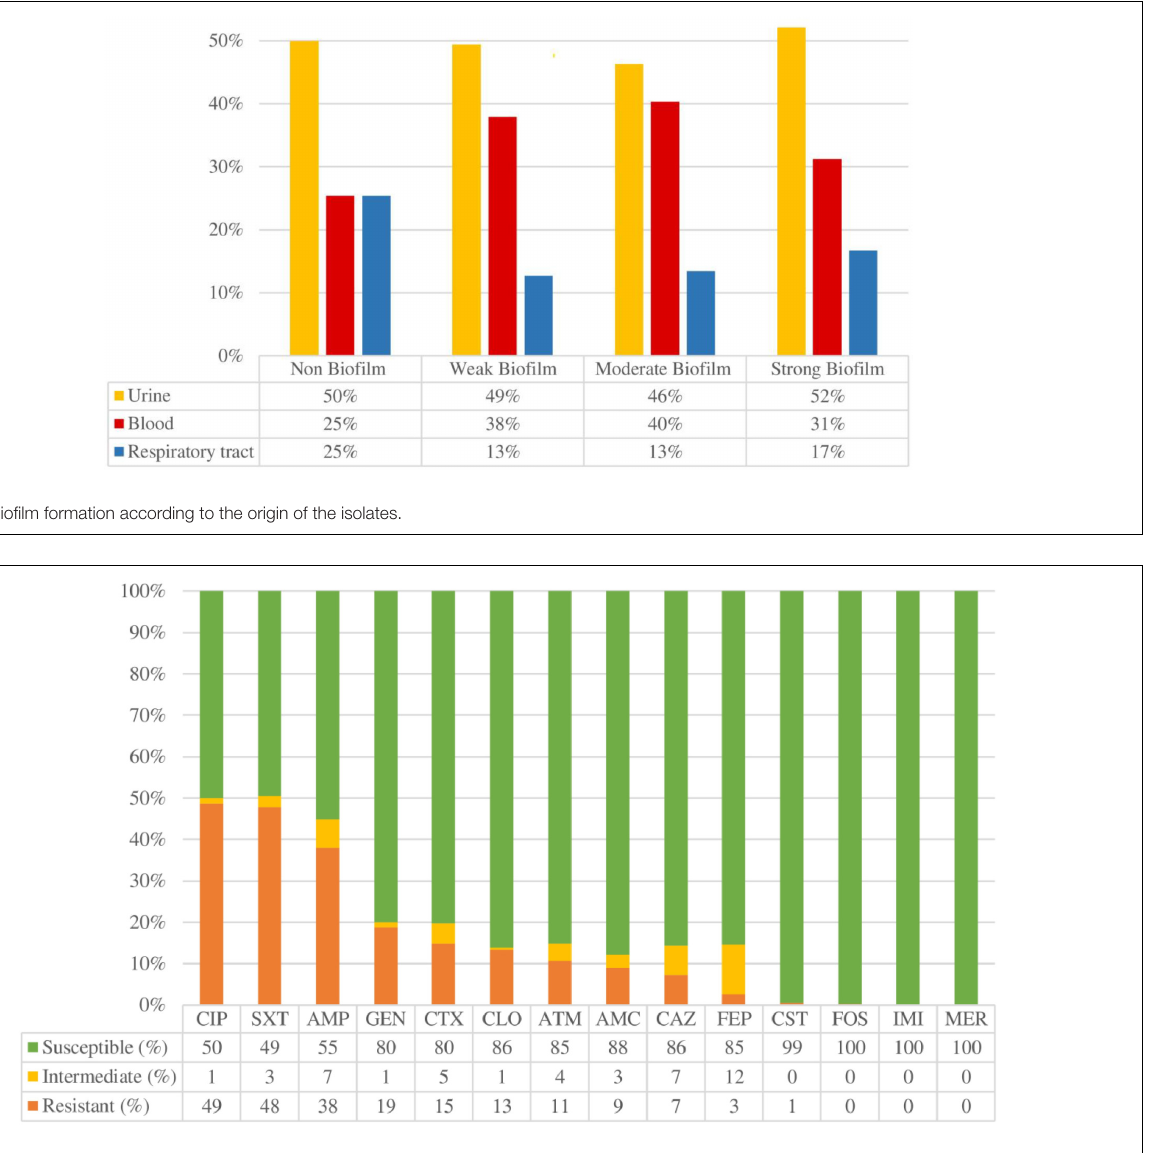
FIGURE 2 | Overall antimicrobial resistance rates expressed in percentage (%). AMC: Amoxicillin/clavulanic acid, AMP: Ampicillin, ATM: Aztreonam, CLO: Chloramphenicol, CAZ: Ceftazidime, CIP: Ciprofloxacin, CST: Colistin, CTX: Cefotaxime, FEP: Cefepime, FOS: Fosfomycin, GEN: Gentamicin, IMI: Imipenem, MER: Meropenem, SXT: